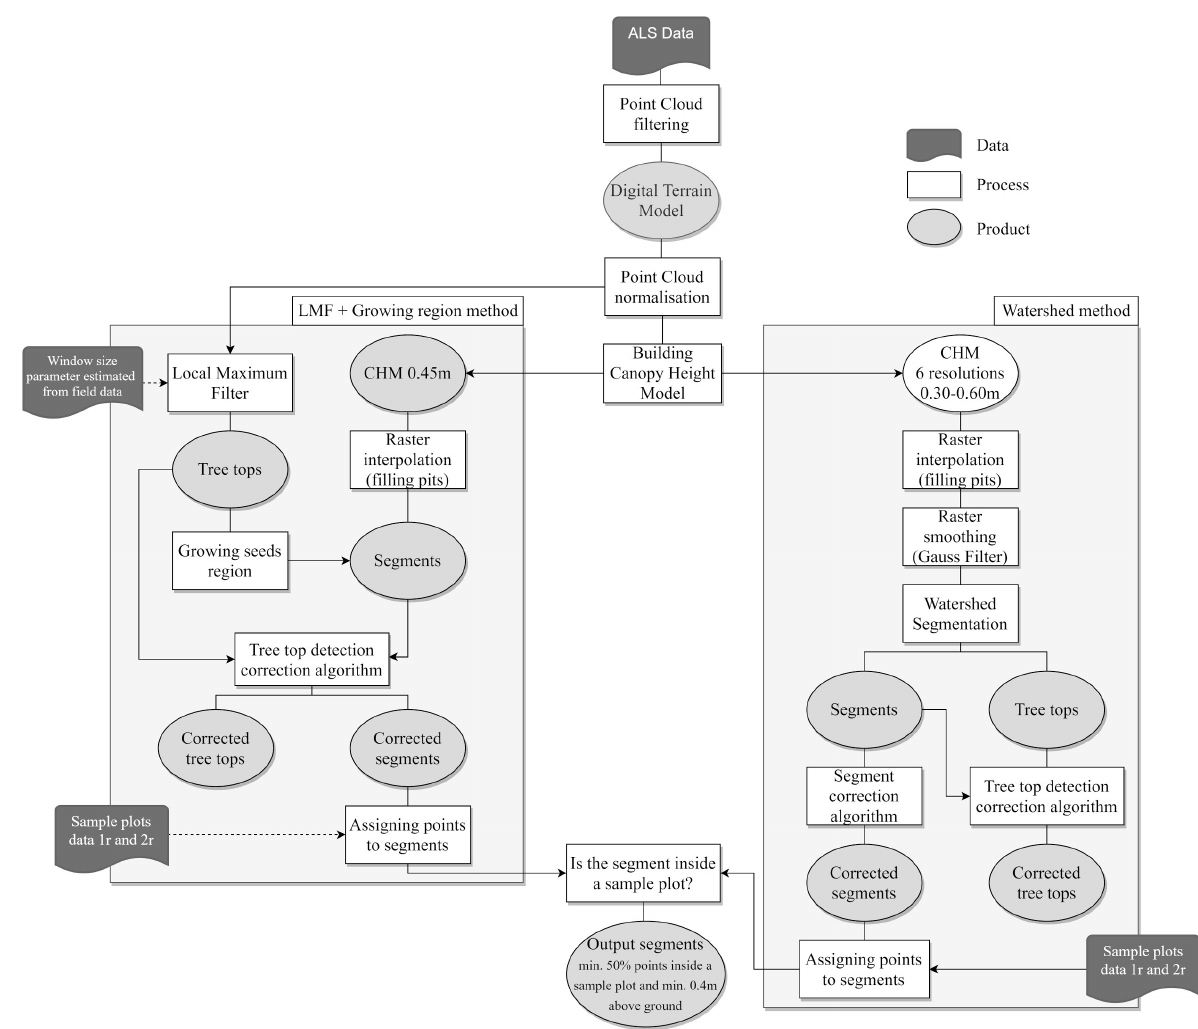
Figure 4. Schematic of the procedures used in the study to determine the number of trees in the sample plots using considered Individual Tree Detection methods utilizing Canopy Height Model